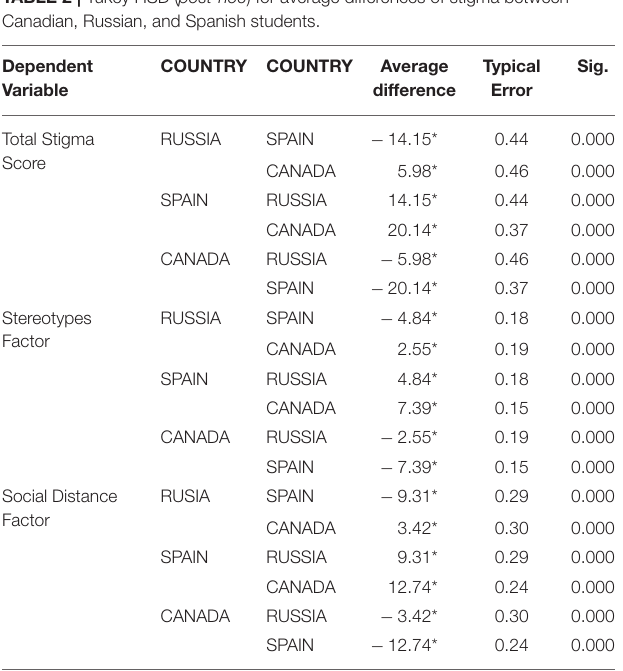
TABLE 2 | Tukey HSD ( post-hoc ) for average differences of stigma between Canadian, Russian, and Spanish students. Dependent COUNTRY COUNTRY Variable